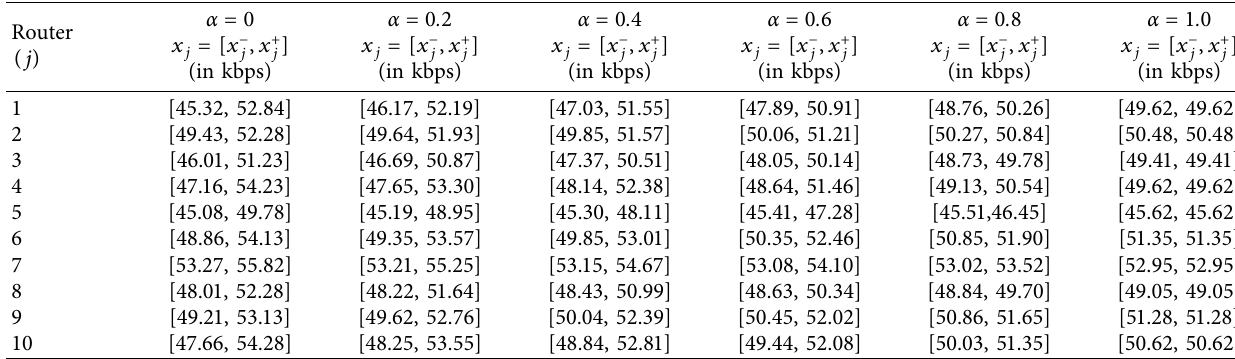
Figure 3: Graphical representation of change of data stream ( 􏽥 x Table 10: Data stream rate in terms of interval for different values of α .